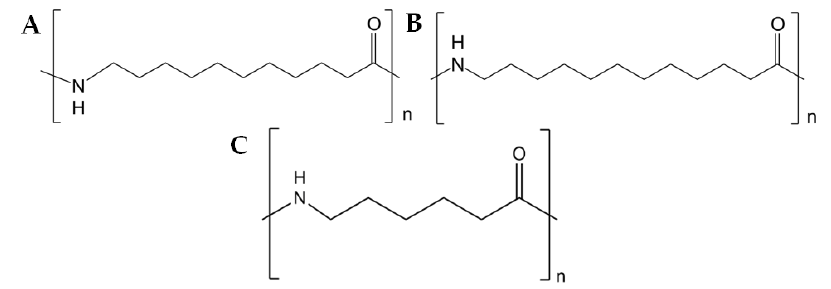
Figure 3. Monomers of polyamides; A—PA 11, B —PA 12, C— PA 6.